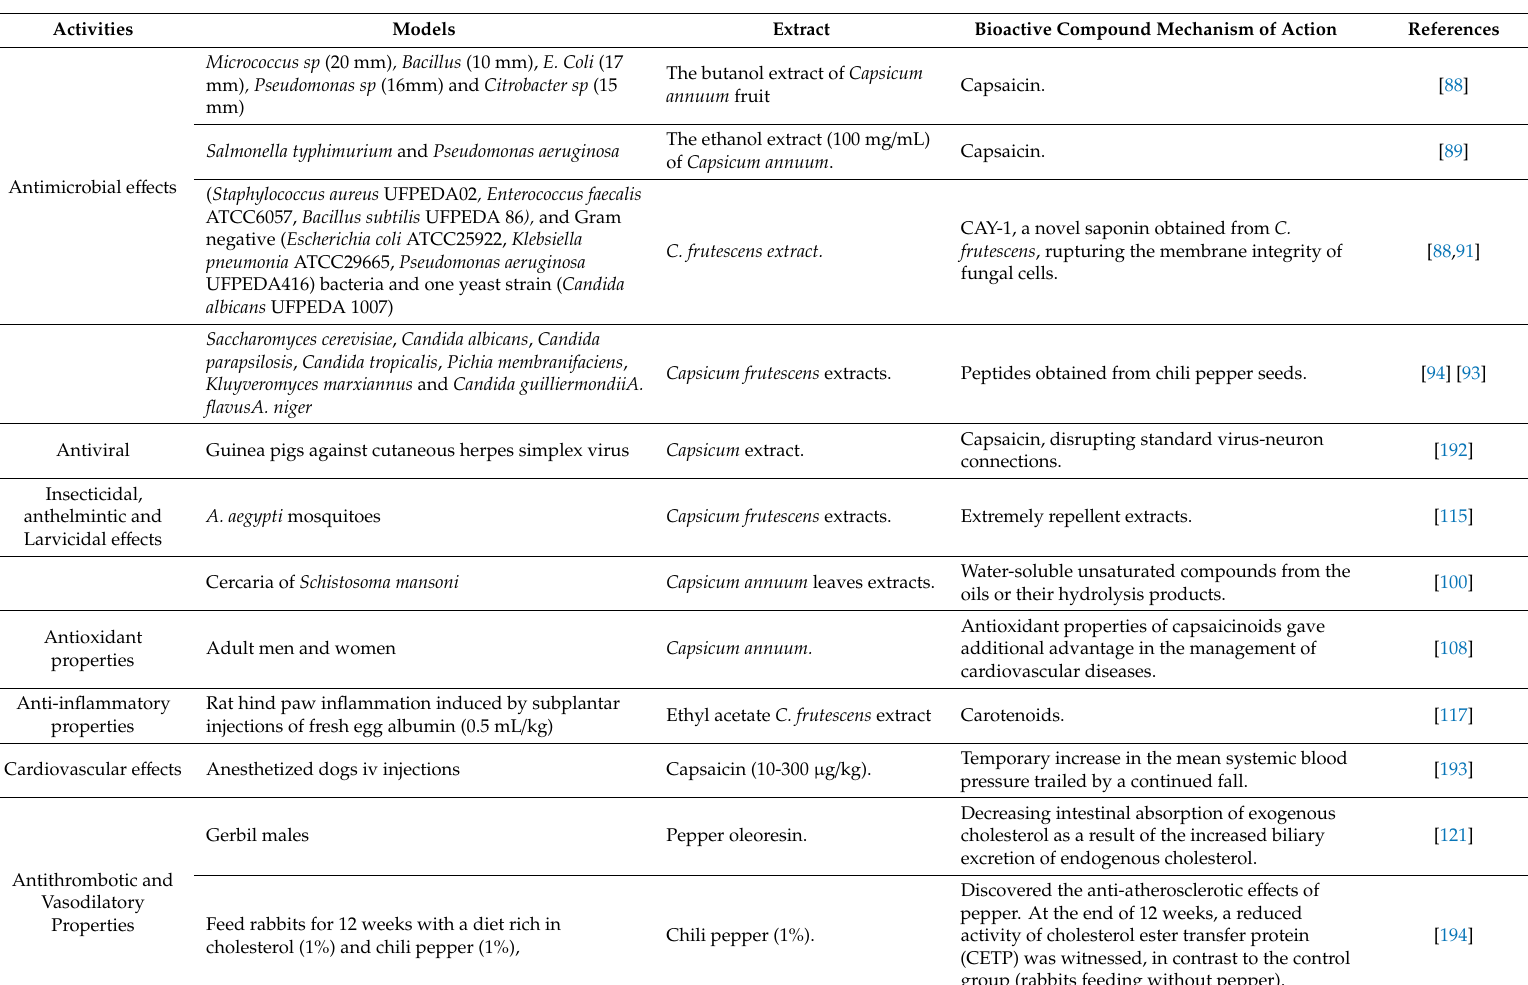
Table 6. The biological activities of Capsicum